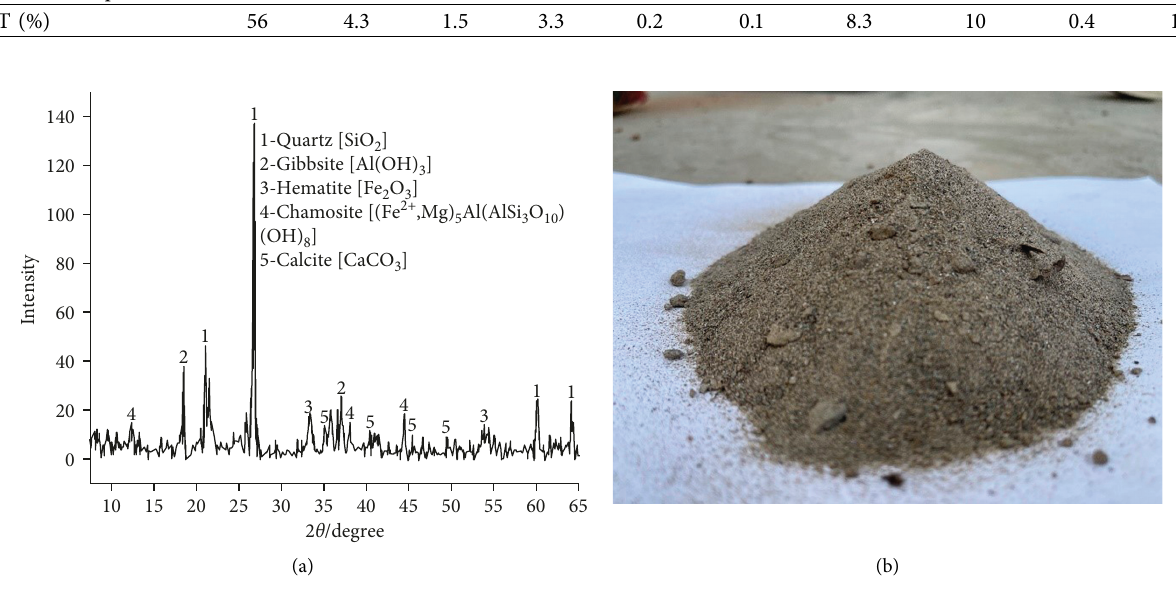
Figure 1: IOT; (a) XRD pattern of IOT; (b) IOT real